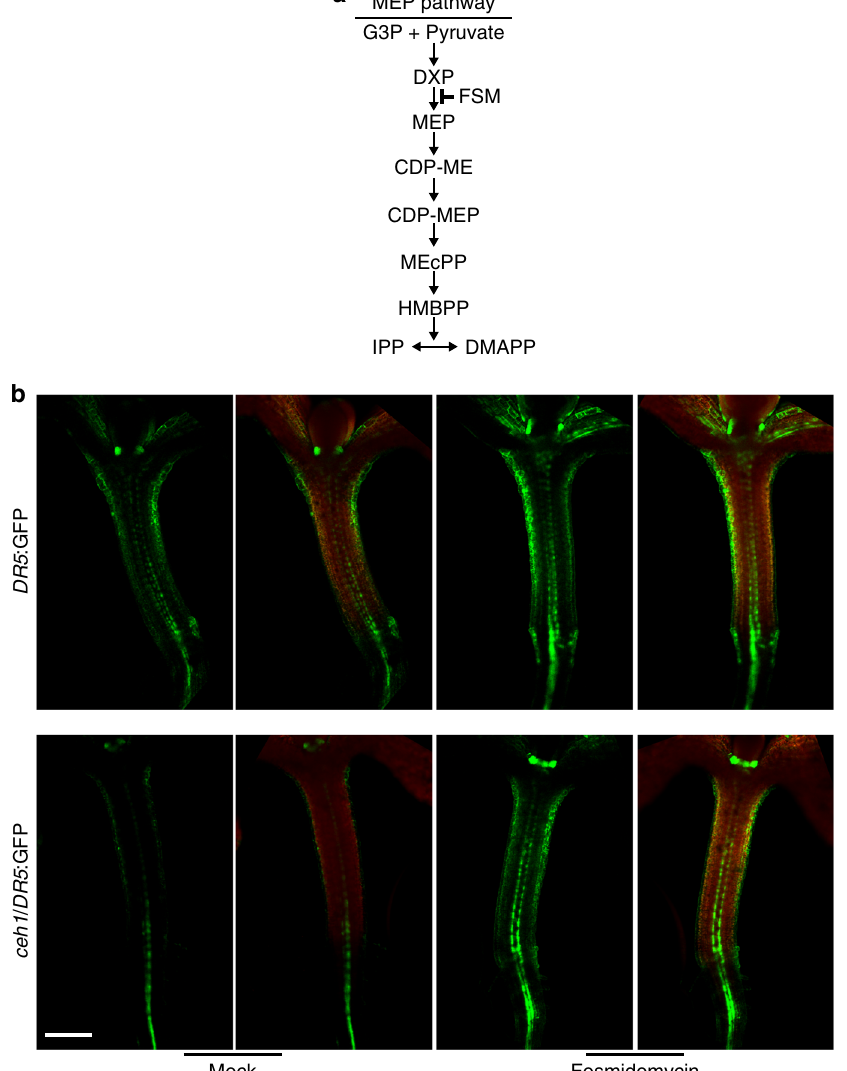
Fig. 2 MEP pathway inhibition by fosmidomycin recovers DR5 :GFP signal in ceh1 seedlings. a Schematic representation of MEP pathway noting the site of fosmidomycin (FSM) inhibitory action. b Representative images of DR5 :GFP (green) in 7-day-old hypocotyls of P ( DR5 :GFP) and ceh1 , chloroplast fl uorescence (red) and the merged images. The experiments were performed three times, each with 10 biological replicates. Scale bar: 100 μ